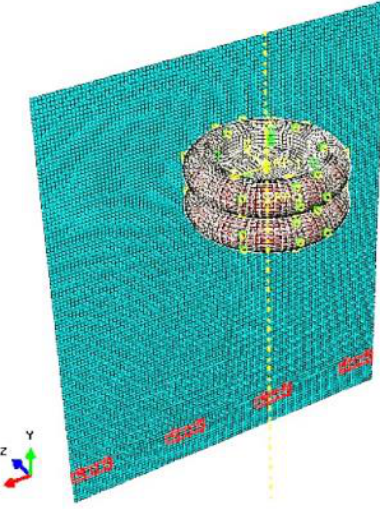
Figure 10. Axonometric view of the SM2 simplified model under the double twin-tyre setup (ABAQUS).